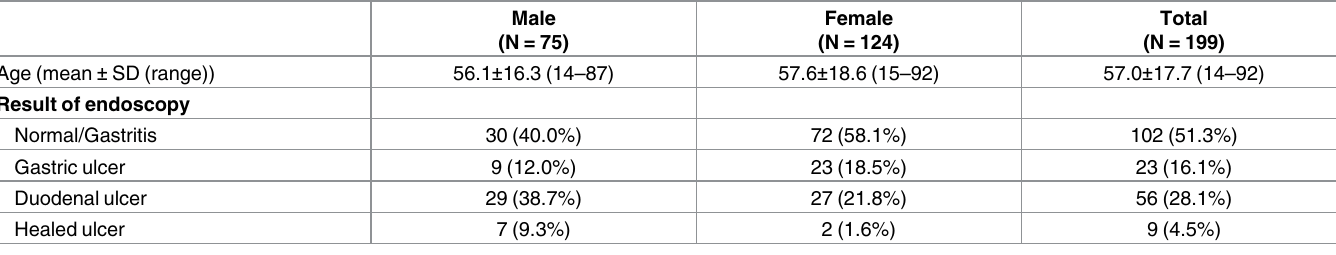
Table 1. Demographic and clinical characteristics of